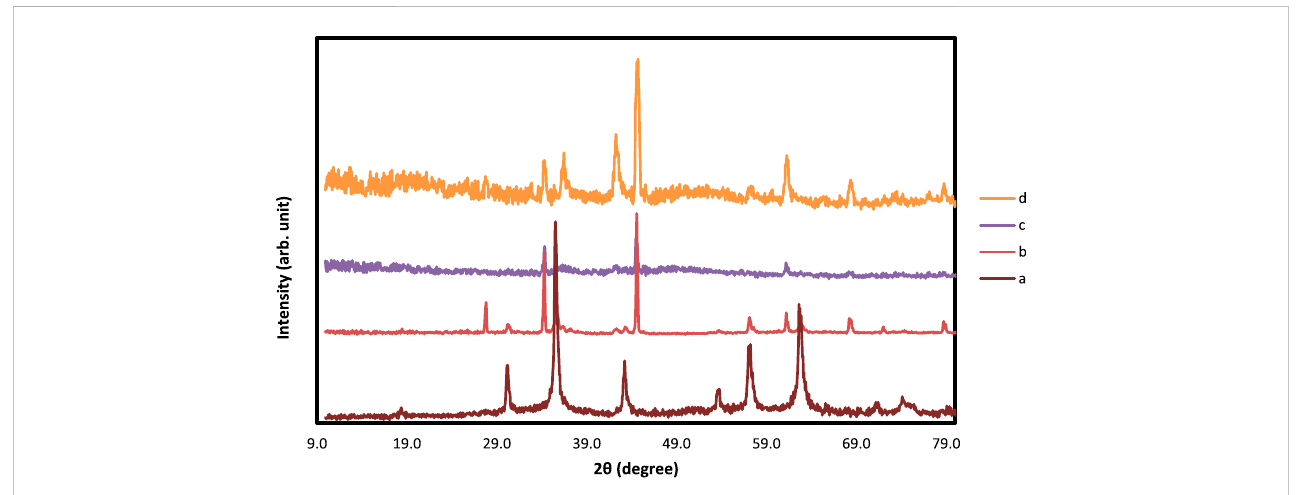
FIGURE 4 XRD analysis of (A) Fe 3 O 4 @SiO2, (B) Ti 3 C 2 -Fe 3 O 4 @SiO 2 -FA, (C) Ti 3 C 2 -Fe 3 O 4 @SiO 2 -FA-Cisplatin, and (D) Ti 3 C 2 @FA.